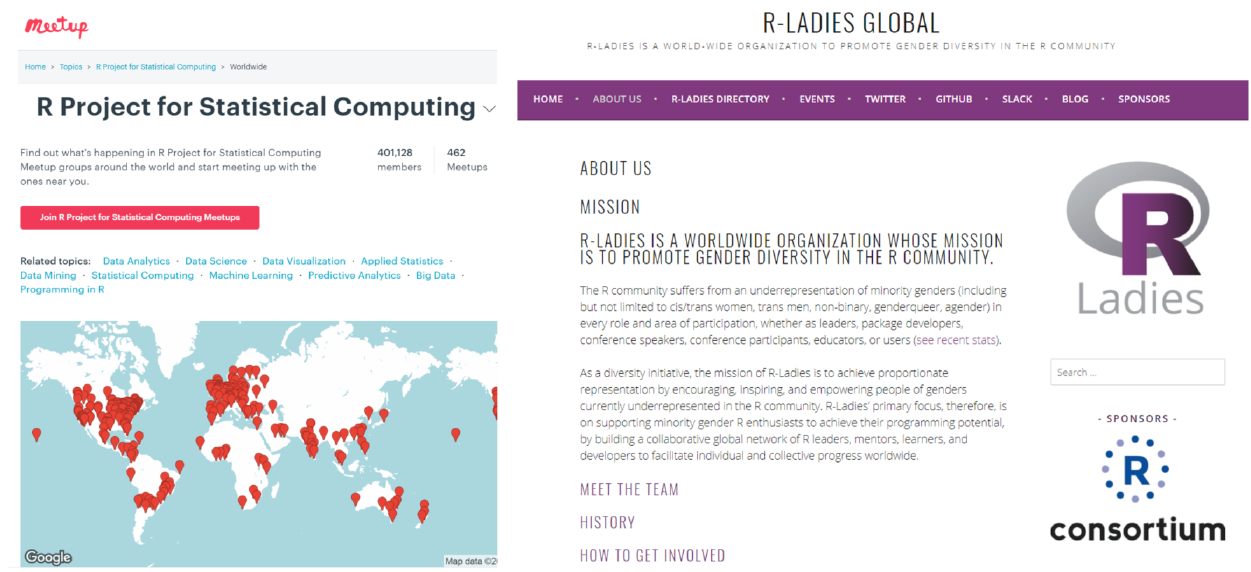
Figure 7. The R community. Left: the R meet-up groups (https://www.meetup.com/topics/r-project-for-statistical-computing). Right: the R-Ladies global organization